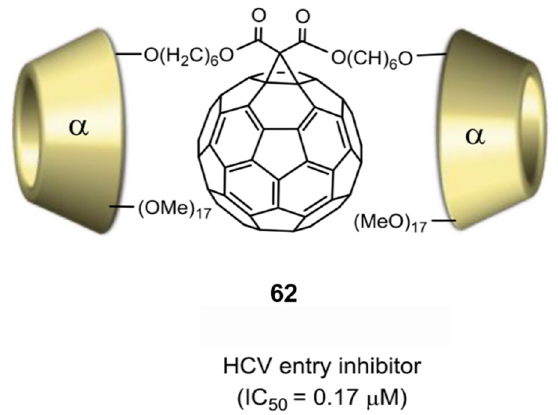
Figure 20. α -Cyclodextrin-C 60 conjugate ( 62 ) [84]. Adapted with permission from Ref. [84]. Copyright 2012 Elsevier.